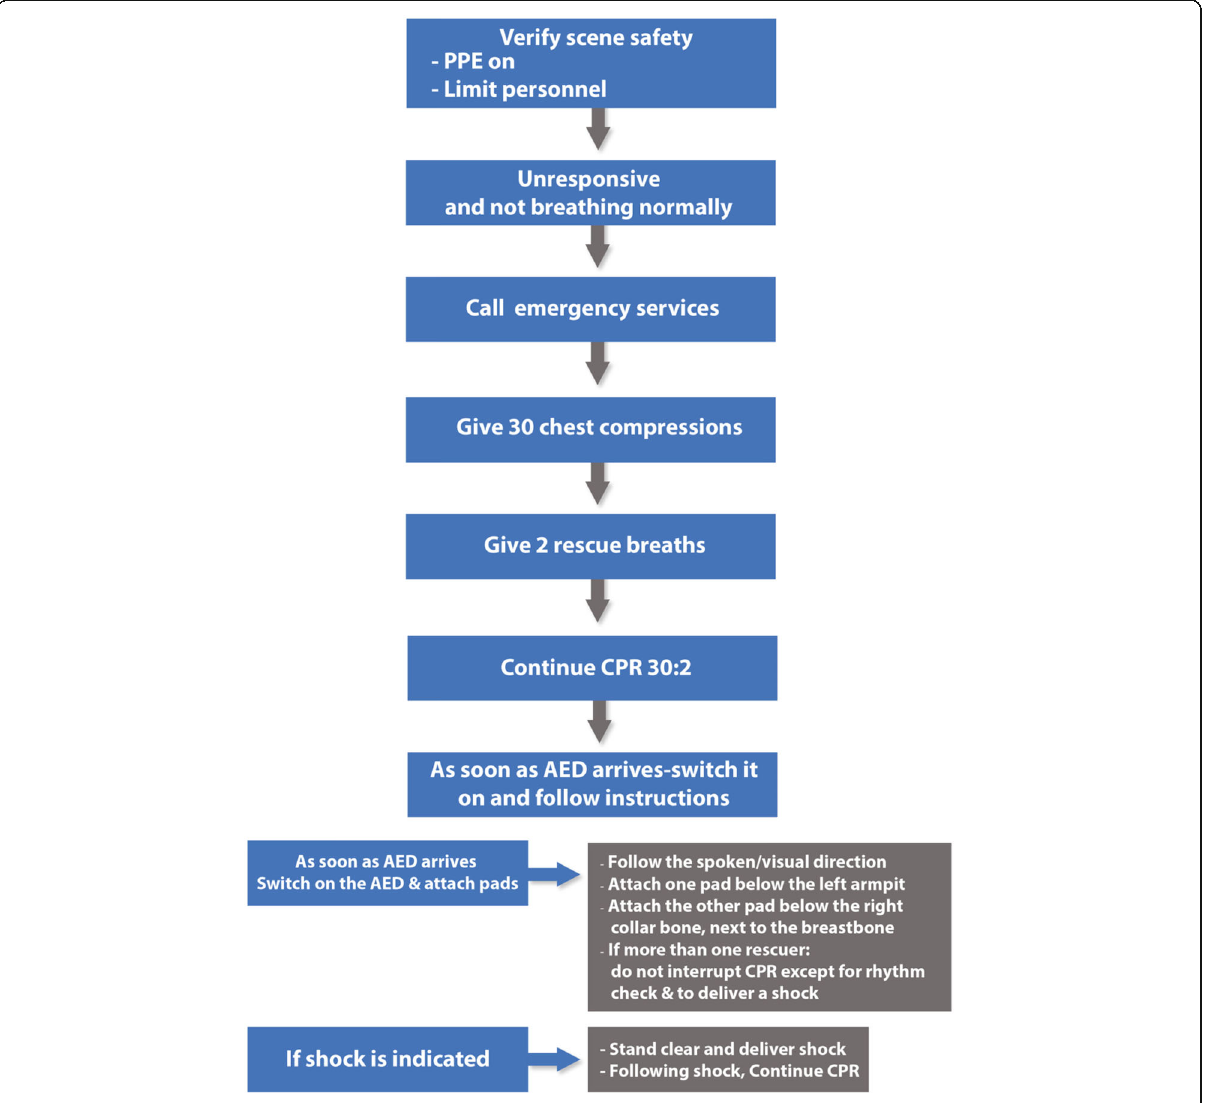
Fig. 1 Basic life support algorithm for adults during the COVID-19